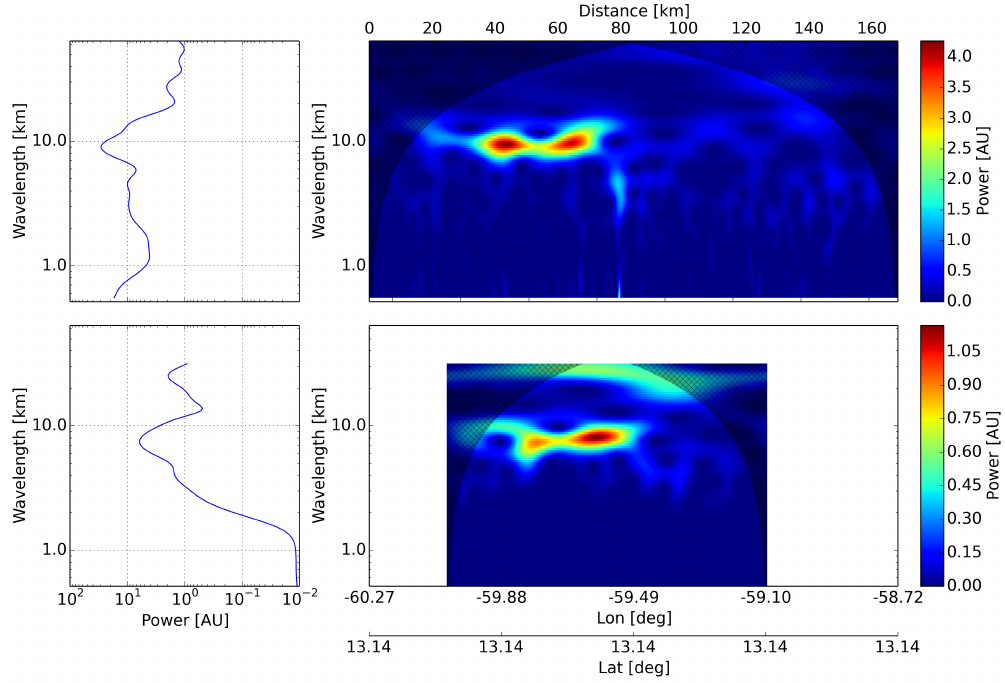
Figure 17. Wavelet analysis of the vertical wind corresponding to the 2nd leg for the flight on 26 June derived from the DWL measurements (Fig. 11b) at 2000m (upper panels) and derived from the LES (Fig. 16b) at 2000m (lower panels). The hatched areas indicate the cone of influence. The left panels show the average power for each